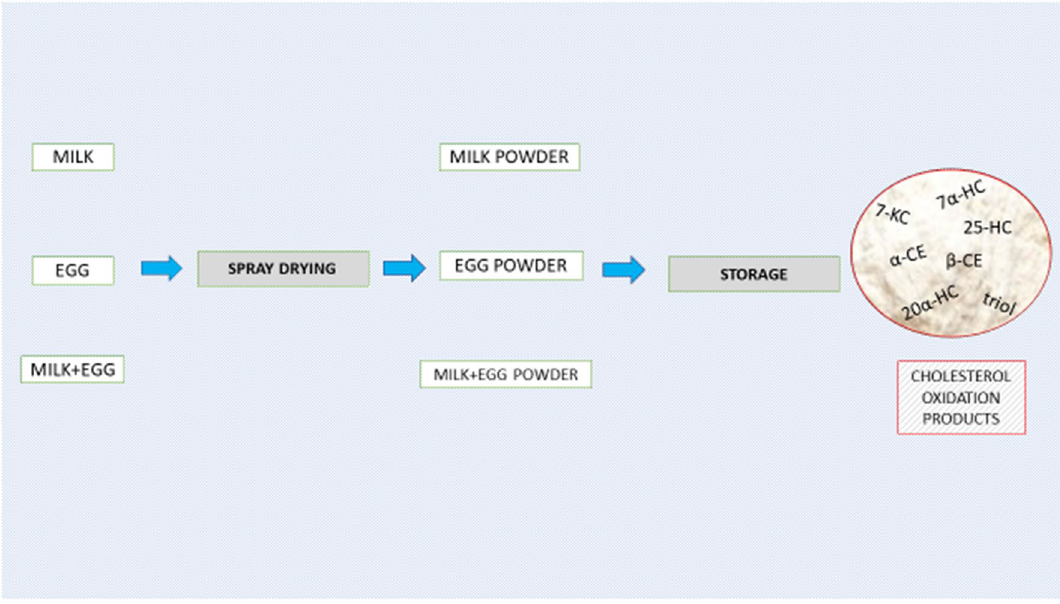
Figure 2. The scheme of